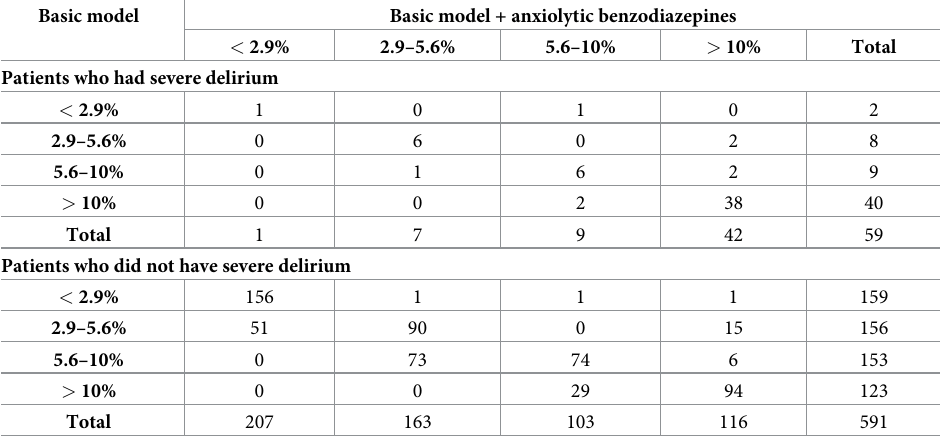
Table 4. Reclassification for the risk of delirium in patients with